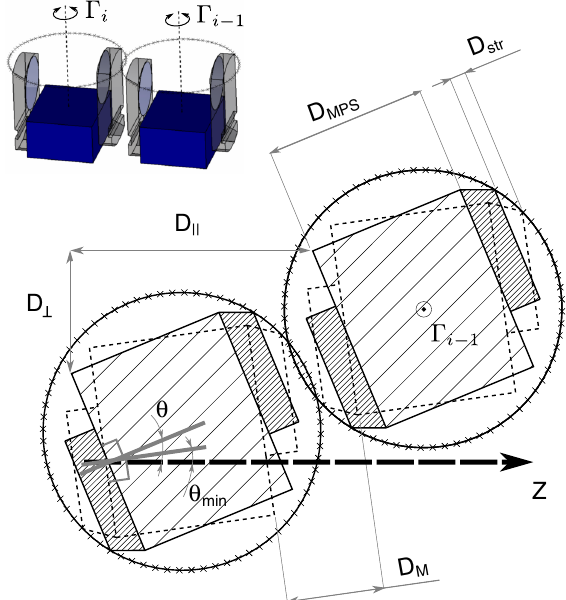
FIG. 5. Two MPS disposition scheme (unrolled view) from the top view of Fig. 3 and the corresponding isometric view given in the inset are shown. The MPS ’ s stroke (circles with crosses), the initial position (hatched) with the corresponding incident angle θ , and the maximal rotated MPS (dotted) with the minimal incident angle θ are represented. D is the stroke generated when the min str MPS is in the maximal rotated position with respect to the initial position. D ⊥ and D ∥ are the distances between the centers of two neighboring MPS in the xy plane and along the z axis,